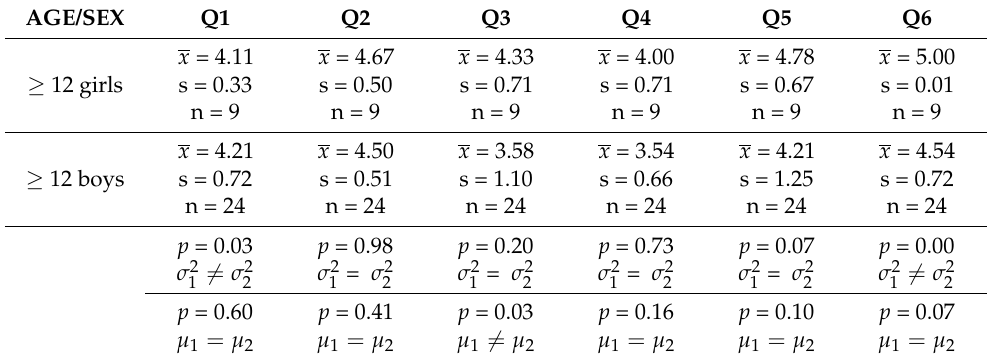
Table 5. Hypothesis test of variances and population means using chi-square and Student’s t -test distributions for girls and boys aged 12 years or older (secondary education).